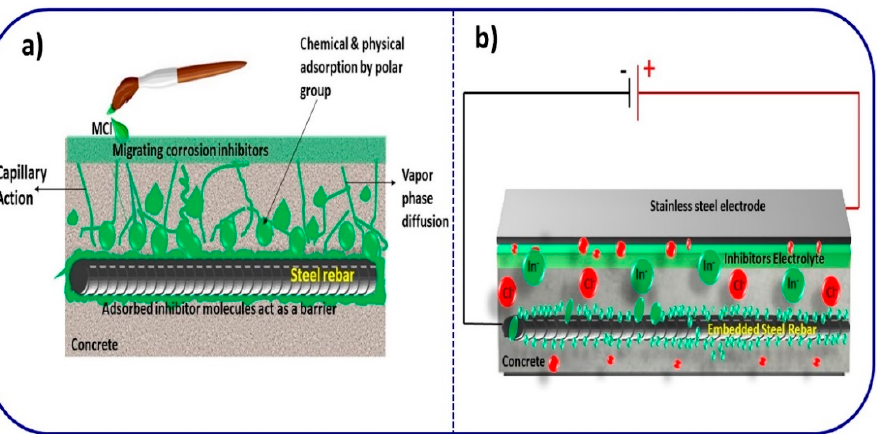
Figure 10. Schematic diagram of the migrating ( a ) and electro-injection ( b ) methods of corrosion inhibition .